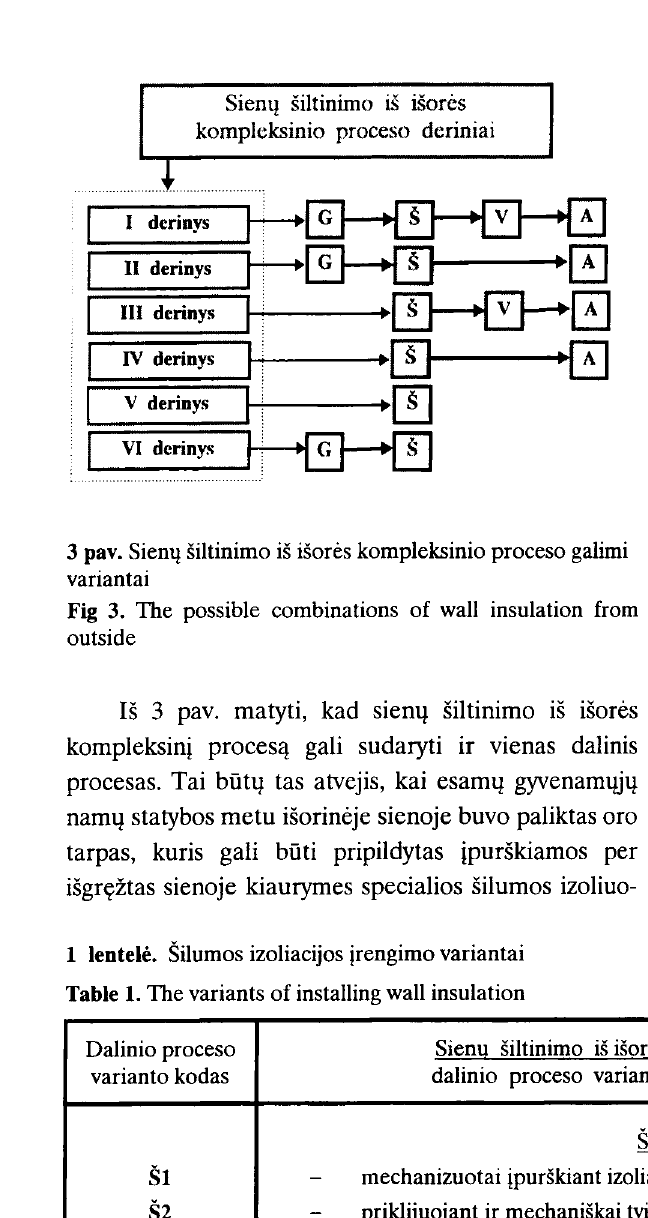
Table 1. The variants of installing wall